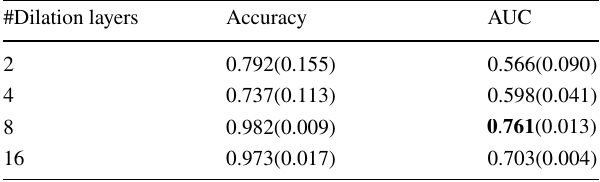
Here the learning rate is set to be 0.001, and the resampling ratio